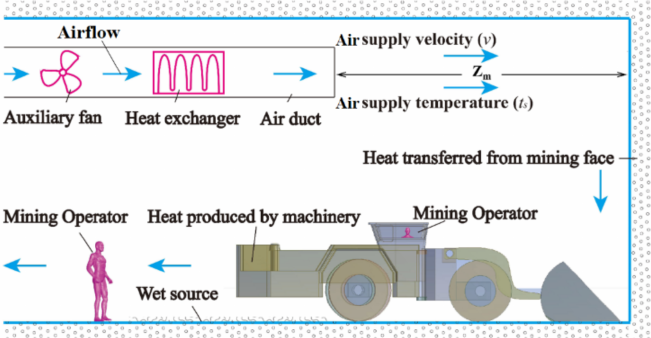
Figure 1. Elements that constitute the thermal environment of an underground heading